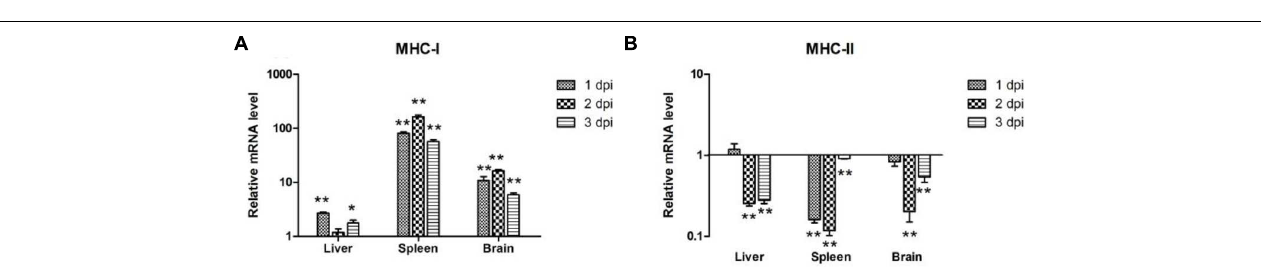
FIGURE 4 | The expression of MHC-I and -II in the liver, spleen, and brain from the APEC-infected ducks. (A) MHC-I, (B) MHC-II. Y- axis represents the fold change of target genes in the experiment groups versus those in control group. Data were expressed as means ± standard deviations ( n = 3). The difference was